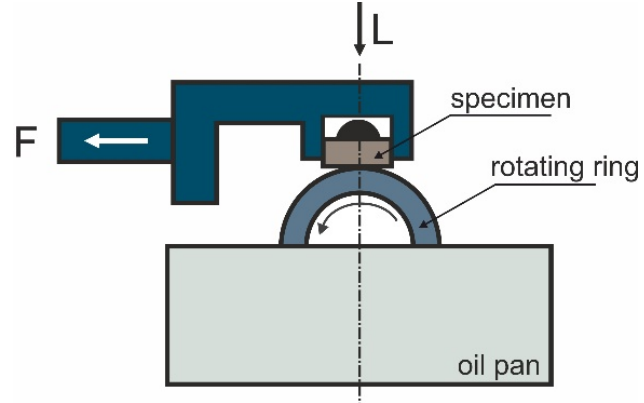
Figure 2. Diagram of test using T-05 tribometer.